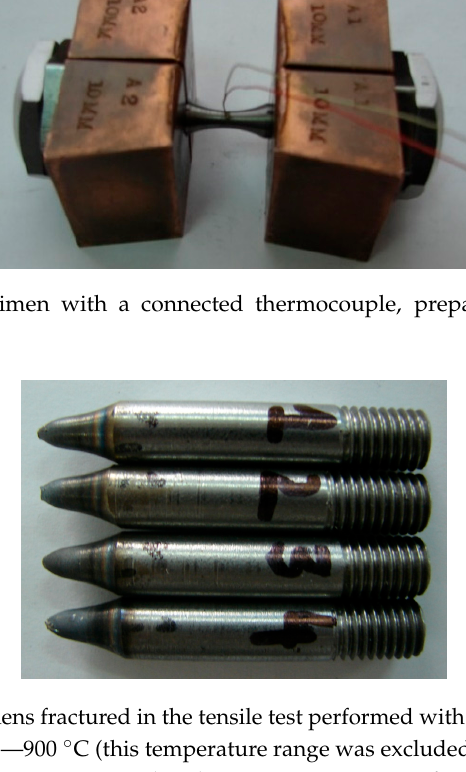
Figure 4. Clamped specimen with a connected thermocouple, prepared for mounting in the Gleeble simulator.